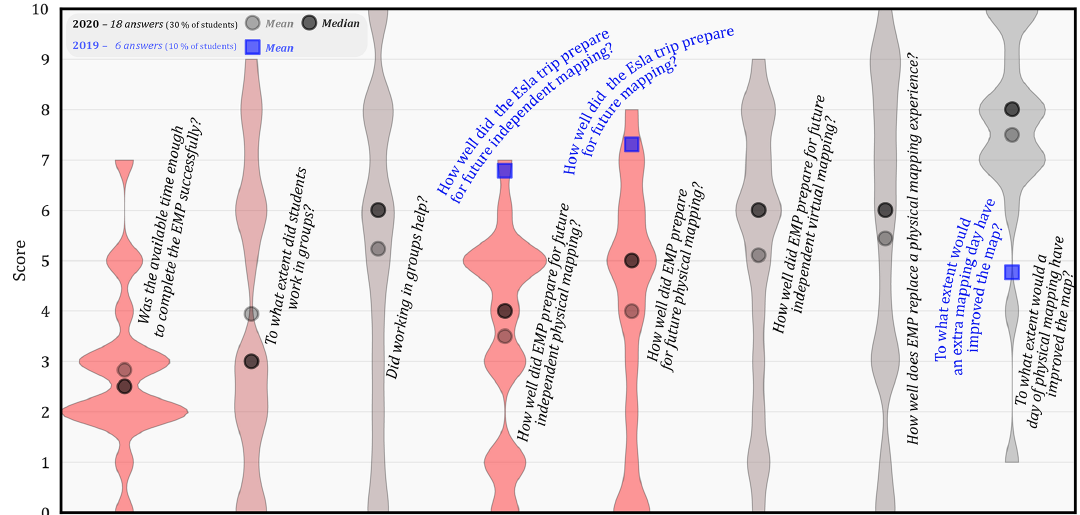
Figure 5. Violin plots (i.e. two-sided histograms) of the students’ answers to a score-based questionnaire (Q2) that surveyed their responses to the Esla Mapping Project. Note the large spread in their answers. In three cases, the same question was posed to previous year students (Q3) that participated in the residential field trip to the Esla Nappe: they are labelled in blue. The 2019 and 2020 percentages are calculated from a number of students of 57 and 60, respectively.